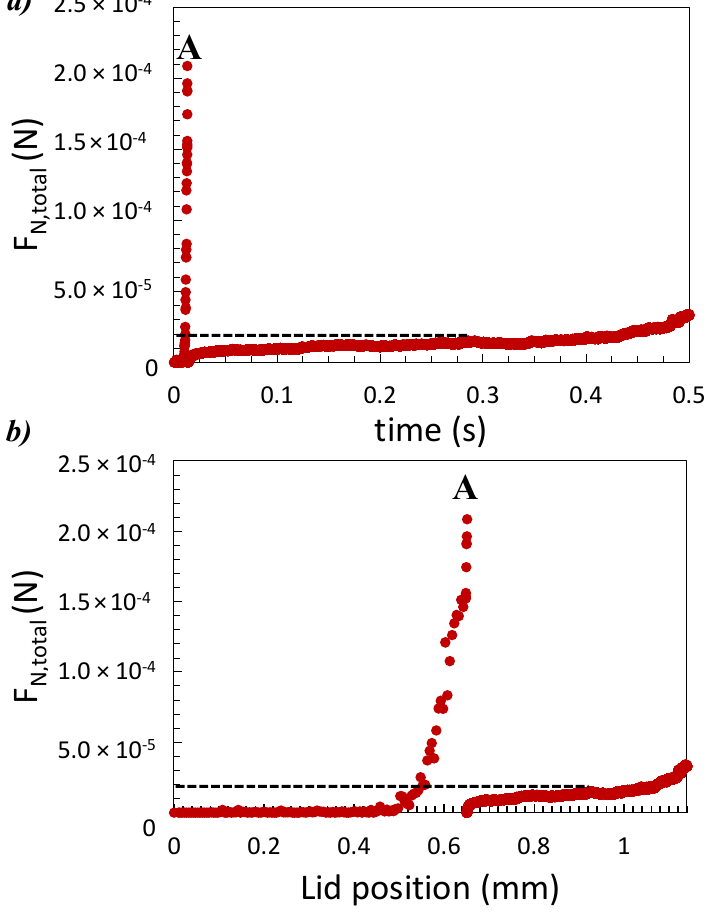
Figure 6. Total normal force exerted by the lid on the powder bed as function of ( a ) time and ( b ) lid position. These graphs have been obtained for Γ = 1 × 10 − 3 J/m 2 and µ R, P − P = 0.8 with a time step of 20% of the critical time step. The first peak (point A) corresponds to the initial compaction of the bed in the consolidation step, the black hyphenated line corresponds to the plateau value of the force assumed valid for the calculation of the unconfined yield strength.